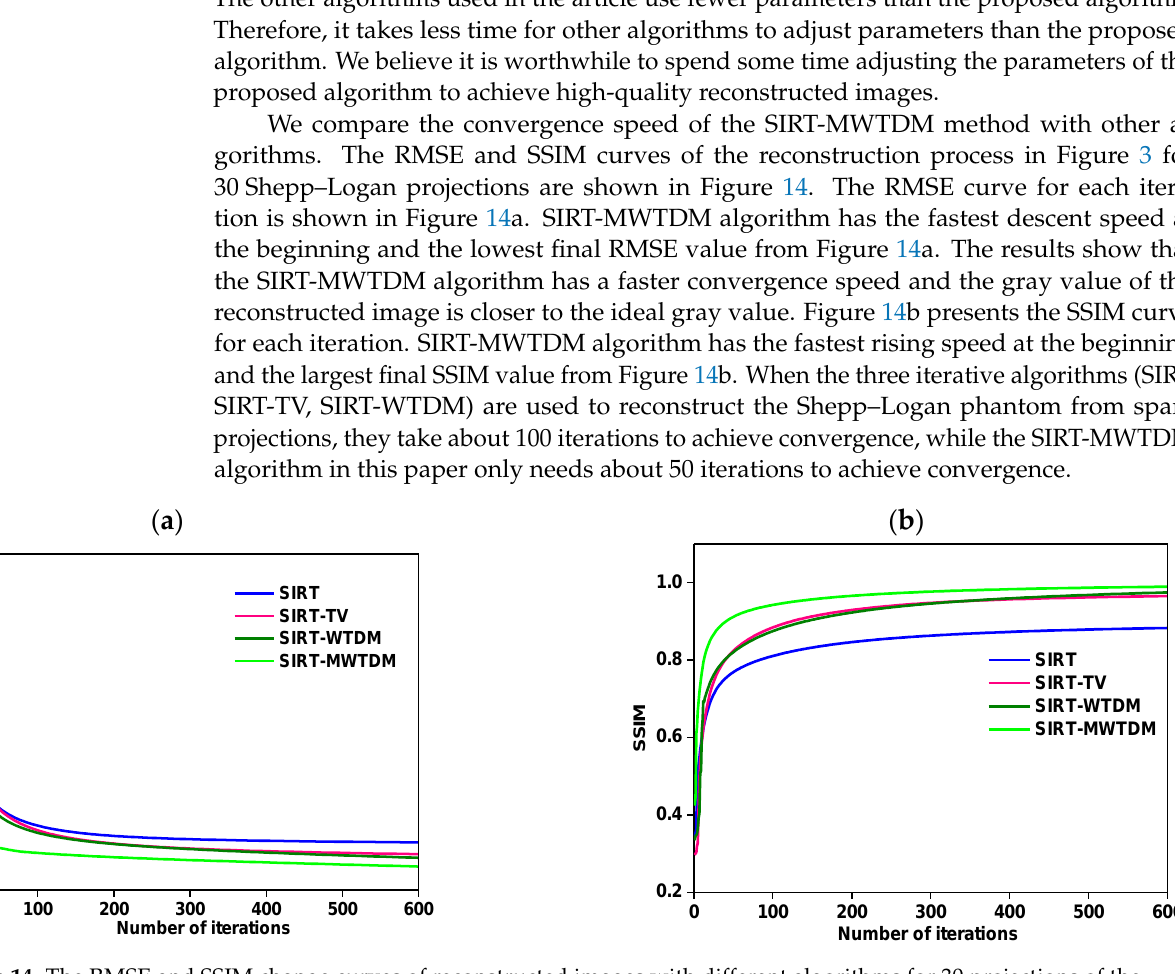
Figure 14. The RMSE and SSIM change curves of reconstructed images with different algorithms for 30 projections of the Shepp–Logan phantom. ( a ) RMSE; ( b ) SSIM.